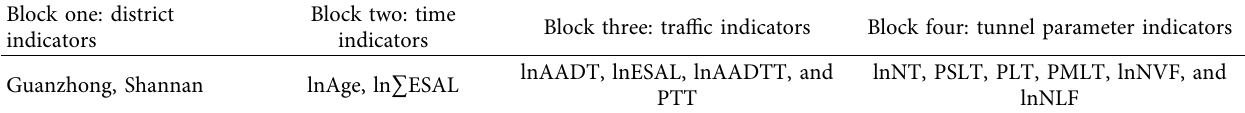
Table 2: Te grouping design of hierarchical regression